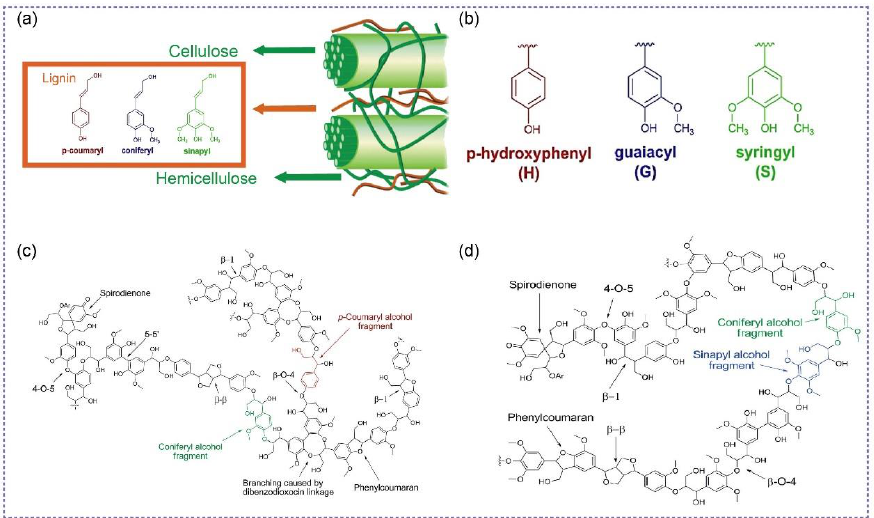
Figure 1. ( a ) The structure of lignin in lignocellulosic biomass; ( b ) three monolignols; schematic representation of a softwood lignin; ( c ) and a hardwood lignin ( d ) structure (From Refs. [9,15,21]).